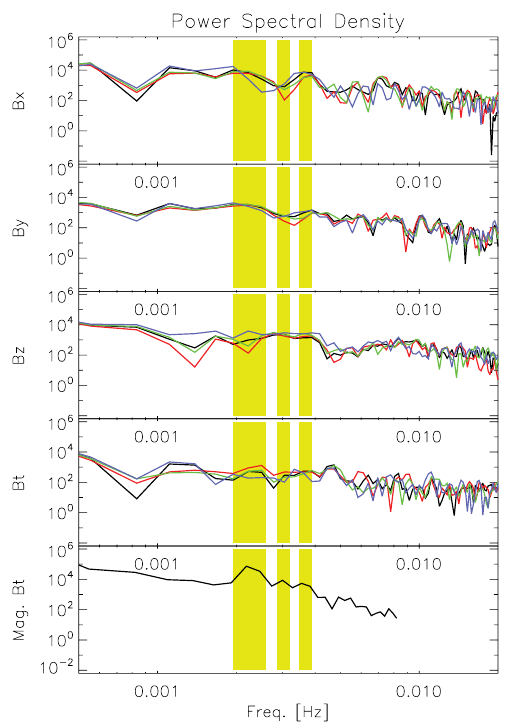
Fig. 10. PSD [nT 2 Hz − 1 ] over the Pc5 frequency range for Event 1 from 05:00 to 06:00UT. The panels represent the PSD of the Clus- ter magnetic field components and total magnetic field, as well as the ground station total magnetic field, respectively. In order, the four spacecrafts are represented in the top four panels by black, red, green, and blue colors. The dominating frequencies in the ground magnetometer data are highlighted in yellow throughout the figure. The frequency range only includes those in the Pc5